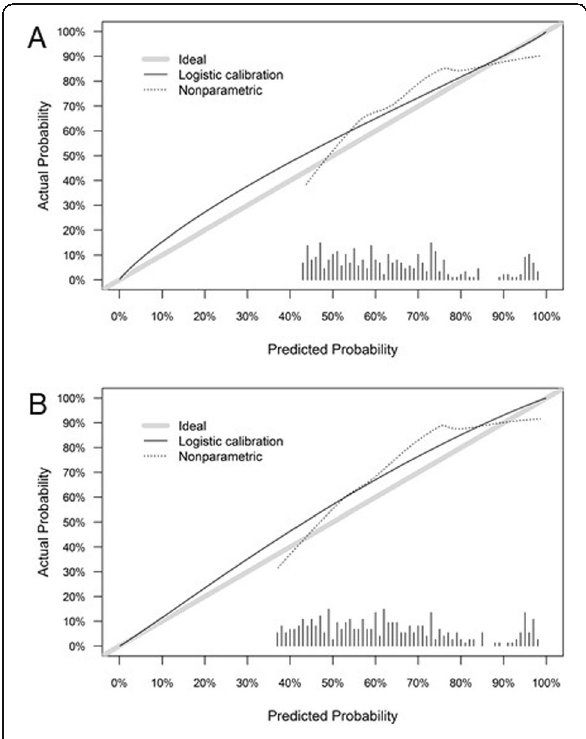
Fig. 3 Local regression nonparametric smoothing (calibration) plot of the compact ( a ) and comprehensive ( b ) prediction model showing the relationship between nomogram predictions and observed frequency of positive 68 Ga-PSMA-11-ligand PET/CT examinations in the validation cohort. Perfect or ideal predictions correspond to the 45° line (grey line). Points situated above the 45° line correspond to overprediction in the validation cohort in comparison to the prediction model, whereas points estimated below the 45° line correspond to underestimation in the validation cohort according to the prediction model (dotted black line). Vertical lines indicate the frequency distribution of predicted